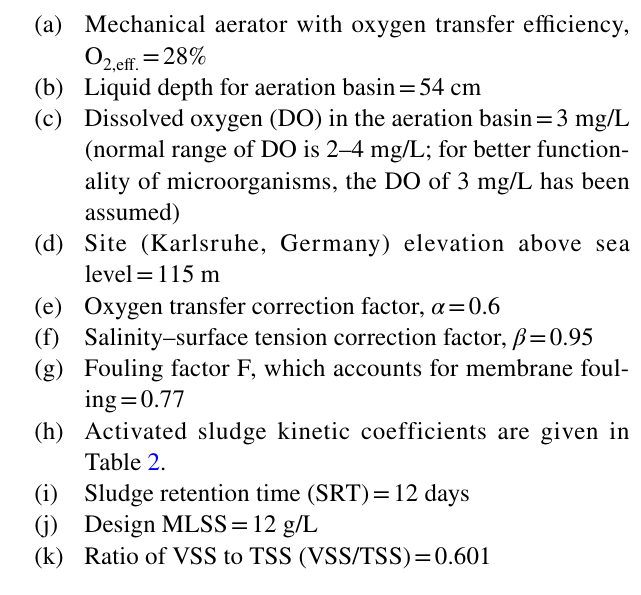
Design parameters